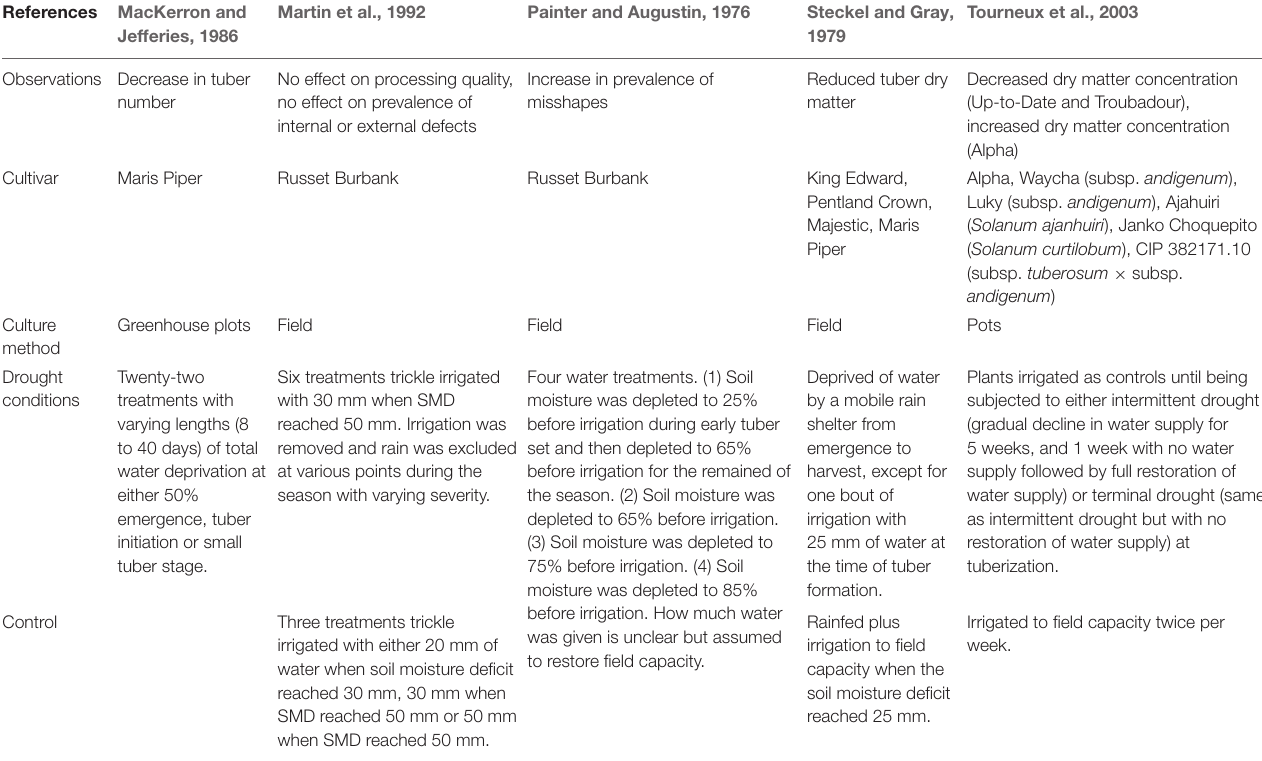
TABLE 3 | A summary of the effects of drought stress on key physiological tuber traits in potato and the range of methodologies by which these variables were